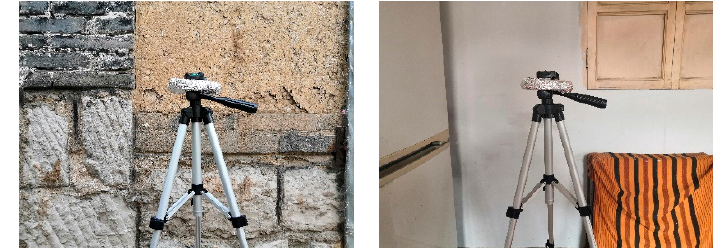
Figure 4. Outdoor and indoor temperature measurement of rural houses.